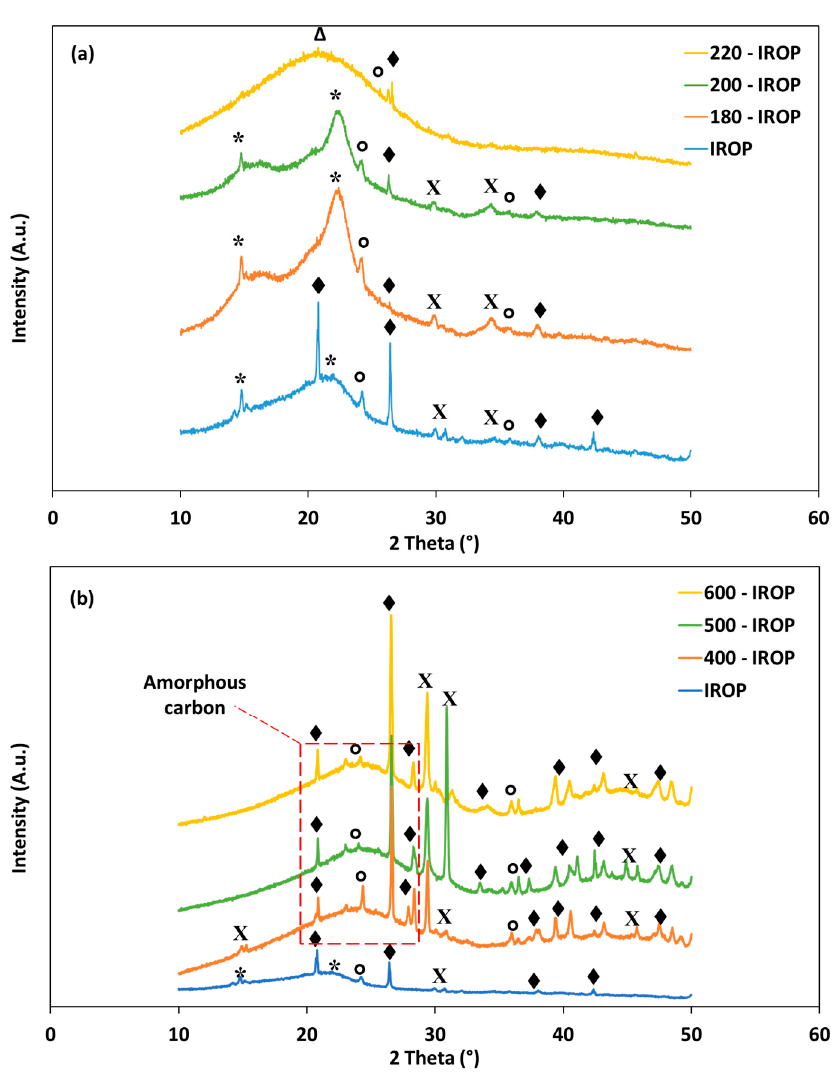
Figure 4. X-ray diffractograms for IROP and the resulting ( a ) hydrochars and ( b ) biochars produced at 180, 200, 220 °C and 400, 500 and 600 °C, respectively (*: Cellulose I, Δ : Amorphous cellulose, ♦ : at 180, 200, 220 ◦ C and 400, 500 and 600 ◦ C, respectively (*: Cellulose I, ∆ : Amorphous cellulose, SiO 2 , X: CaCO 3 , ∘ : Fe 2 O 3 ) . (cid:7) : SiO ◦ : Fe 2 , X: CaCO 3 , 2 O 3